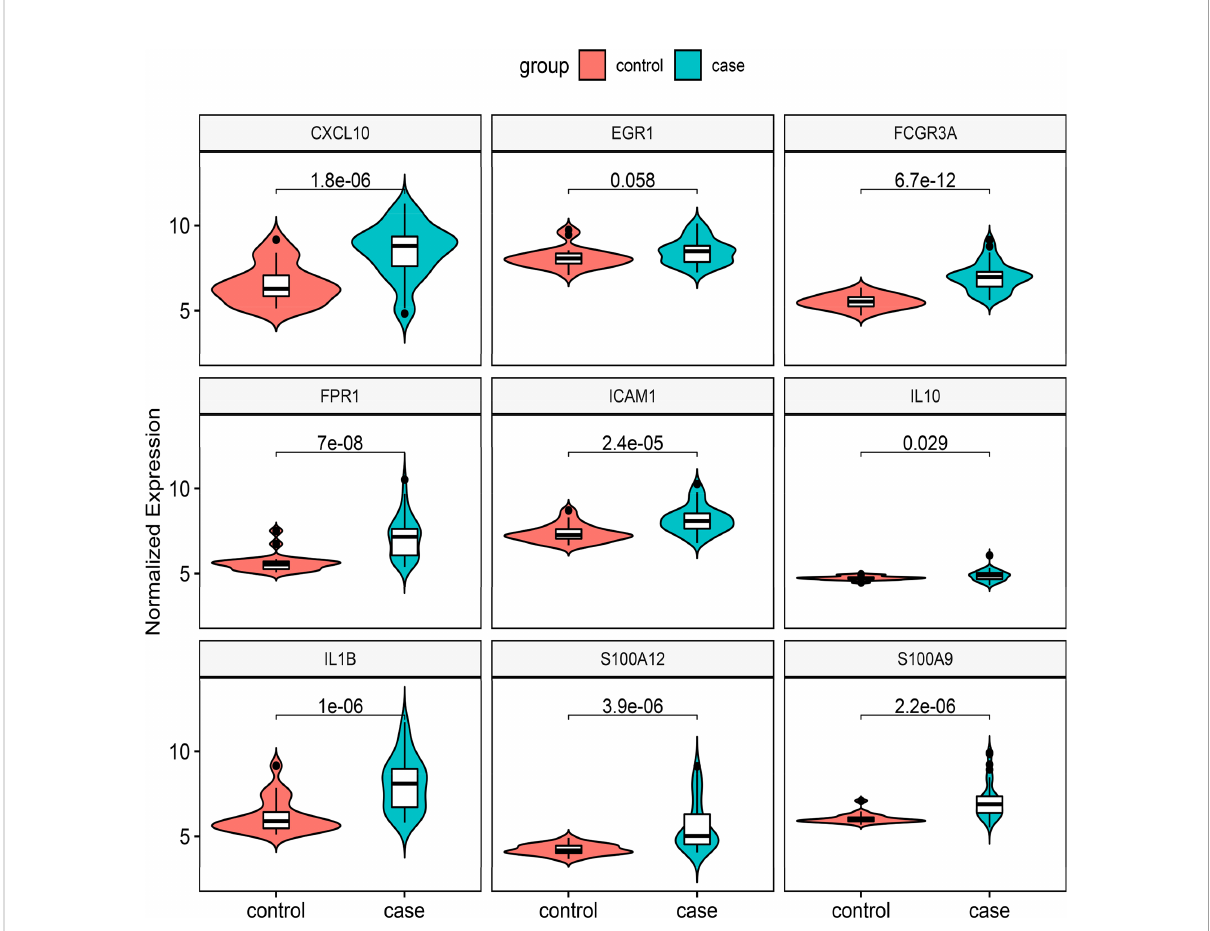
FIGURE 5 Validation of the nine hub genes ’ expression in external CD gene expression pro fi le (GSE126124). CD, Crohn ’ s